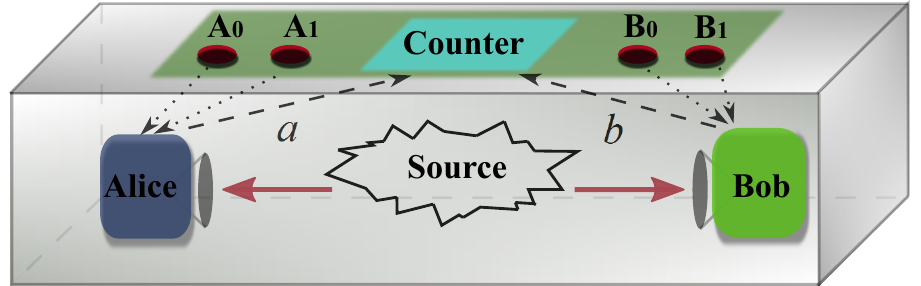
Figure 1. Schematic diagram for quantum steering. Two spatially separated parties, Alice and Bob, share a quantum state and they want to certify whether it is steerable. Alice performs a set of black-box measurements A i , while Bob’s performs quantum measurements B i . The statistics of the outcomes of the measurements are used to verify a violation of the steering